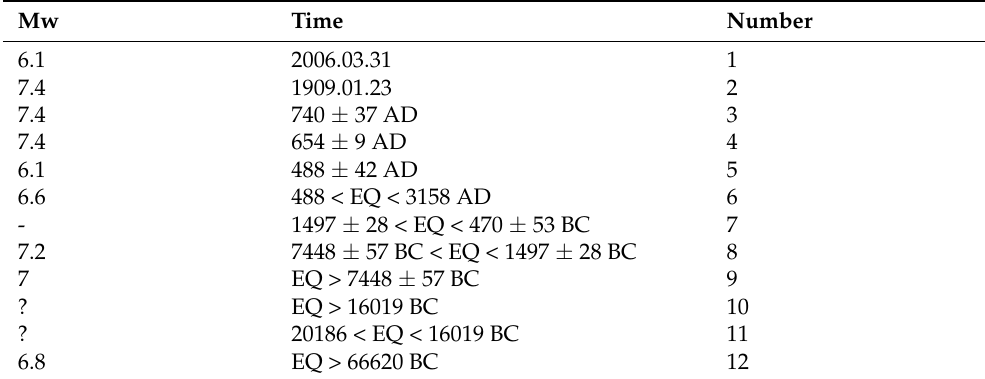
Table 5. The seismic catalog of the Doroud Fault correlated by results of paleoseismology. Historical and instrumental data for earthquakes with magnitude more than MW >